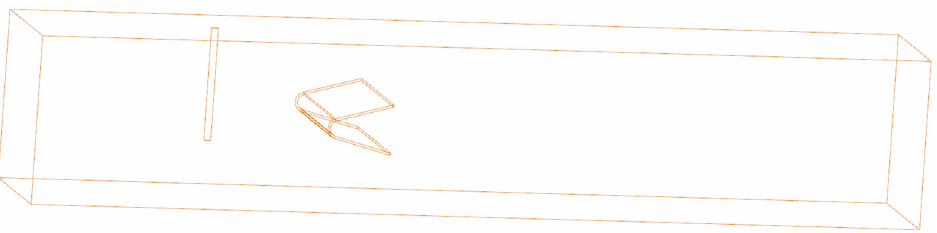
Figure 1. Schematic diagram of the calculation domain model.